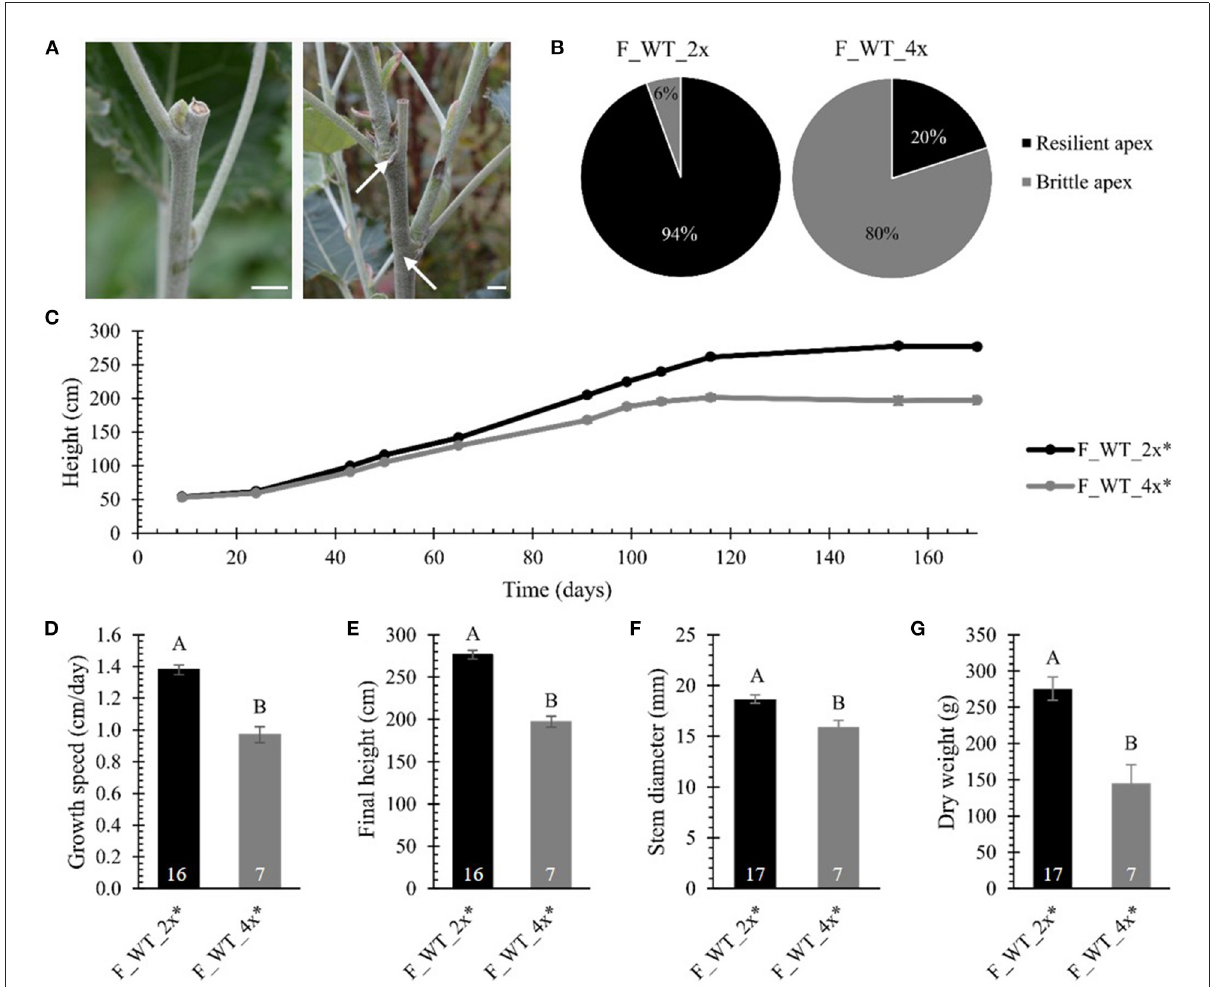
FIGURE4 Biomass yield of field-grown di- and tetraploid poplar trees. (A) Broken tips of tetraploid poplar trees. Arrows point to axillary buds below the broken tip that grew out, resulting in a bushy phenotype. Scale bars = 1cm. (B) Percentage of poplar trees showing the brittle apex phenotype (day = 170). (C) Height over time. The height of the main stem was measured at 11 time points over a period of 170 days. (D) Growth speed. (E) Final height of the poplars measured at day 170. (F) Stem diameter measured at harvest time 50cm above soil. (G) Total dry weight of the debarked tree measured at harvest time. Only field-grown trees that did not develop the brittle apex phenotype were included in the analysis, as specified with the asterisk (*). The number of biological replicates is indicated in the bars. Data shown are adjusted mean ± standard error of the mean (SEM). Different letters represent significant differences at the 0.05 significance level. The significance differences for (C) are provided in Supplementary Table 3. For a detailed description of the models fitted to the data and the statistical tests used, see Supplementary Materials and Methods